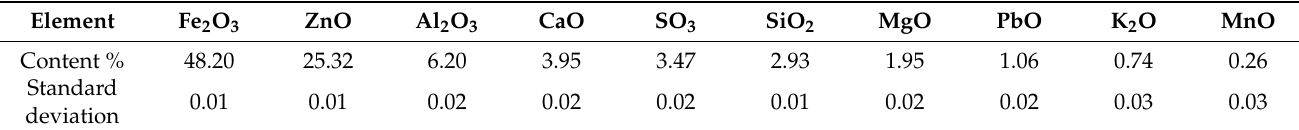
Table 1. Chemical composition analysis of zinc-bearing dust sludge (content.%).